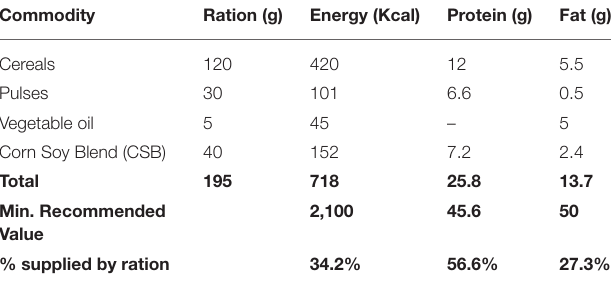
TABLE 4 | Daily food ration per pupil in school feeding programs in Chamwino District. Commodity Ration